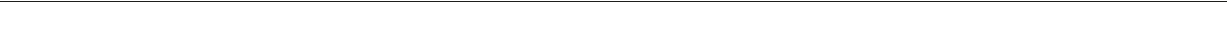
Fig. 3 Empirical modeling demonstrates that MetaNeighbor readily identi fi es rare and transcriptionally subtle cell types. a Schematic of the empirical model. For simplicity only a single dataset is depicted. (Top left) In this dataset, we begin with an expression matrix containing gene expression levels for two cell types comprising 10 cells each. Here we will be assessing the replicability of cell type 1 ( “ positives ” ) relative to cell type 2 ( “ negatives ” ). (Top right) We fi rst adjust cell rarity by randomly sampling subsets of the original expression matrix. In the schematic, incidence is set to 20% (two positives and eight negatives). In addition, we partition two negatives from the original data for later use. (Middle) Next, we adjust transcriptional subtlety by randomly sampling genes from a given fraction of the transcriptome. Gene expression in the positives will be replaced with data from the unused negatives, creating a modeled cell type varying from the negative class only in a subset of its genes. (Bottom) All datasets are combined and MetaNeighbor is run to assess the replicability of the positives at each level of rarity and subtlety. b MetaNeighbor results for empirical modeling of excitatory neuron rarity and subtlety, repeated 100 times. Mean performance for the top GO group is in black; performance for 20 randomly chosen genes is shown in red; dashed lines indicate 20% rarity and solid lines show 1% rarity. MetaNeighbor is robust to differences in cell rarity, and can reliably distinguish between types even when they are very similar (AUROC> 0.7 at >88% subtlety). c MetaNeighbor results for empirical modeling of excitatory neuron rarity and subtlety using highly variable genes (HVGs), repeated 100 times. Performance for the HVG varying set is shown in black, performance for the HVG static is shown in red; dashed lines indicate 20% rarity and solid lines show 1% rarity. HVGs allow for robust identi fi cation of positives even when cells are rare or differences